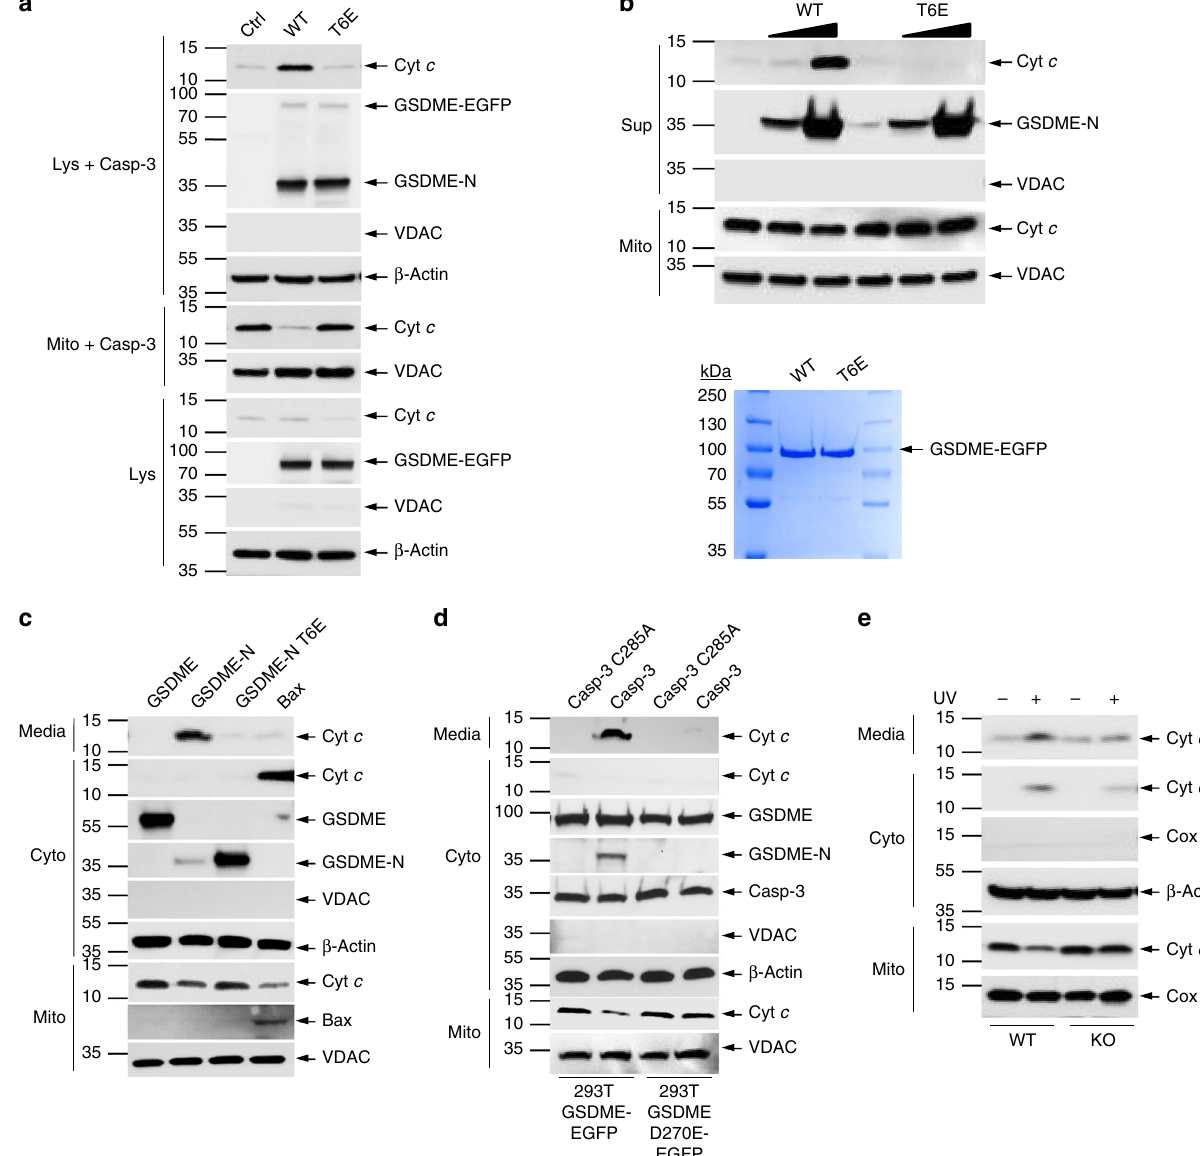
Fig. 5 GSDME-N induces cytochrome c (Cyt c ) release from the mitochondria. a Immunoblots of Cyt c (1st panel) released from puri fi ed mitochondria incubated with recombinant caspase-3, and S100 lysates from control (Ctrl) HEK293T cells or from HEK293T cells stably expressing wild-type (WT) GSDME-EGFP (WT) or GSDME-T6E-EGFP (T6E). (Lys + casp-3): S100 lysates after incubation with caspase-3 and mitochondria followed by removal of mitochondria by centrifugation. (Mito + casp-3): mitochondrial pellet obtained at the end of the reaction. (Lys): S100 lysates before incubation with caspase-3 or mitochondria. b , Upper Immunoblots of Cyt c (1st panel) released into the reaction supernatant (Sup) from puri fi ed mitochondria (Mito) incubated with or without caspase-3 and WT GSDME-N (WT) or inactive GSDME-N-T6E (T6E) mutant (2nd panel). b , Lower Coomassie-stained sodium dodecyl sulfate (SDS)-gel of the puri fi ed full-length WT GSDME-N-EGFP (WT) or inactive GSDME-N-T6E (T6E) used in this experiment. c Immunoblots of Cyt c (1st and 2nd panels) released into the culture media (media) or cytosol (Cyto) from 293T cells transfected with constructs encoding GSDME, GSDME-N, GSDME-N-T6E, or Bax. d Immunoblots of Cyt c (1st and 2nd panels) released into the culture media (media) or cytosol (Cyto) from stable 293T cells expressing WT GSDME (293T-GSDME) or the uncleavable GSDME-D270E (293-GSDME-D270E) transfected with constructs encoding constitutively active caspase-3 (Casp-3) or inactive caspase-3 mutant (Casp-3-C285A). e Immunoblots of Cyt c (1st and 2nd panels) released into